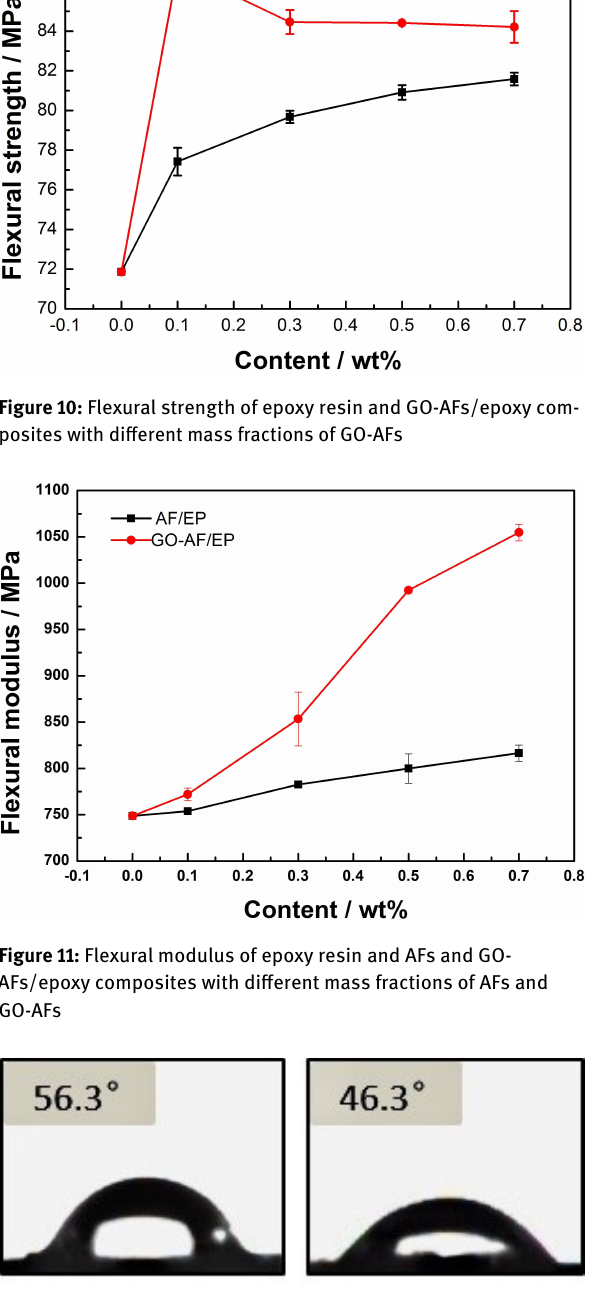
to the fact that the flexural strength of the composite mate- rial strongly depends on the interfacial adhesion between fiber and matrix [41]. It is expected that the introduction of hydrophilic GO can not only increase the surface